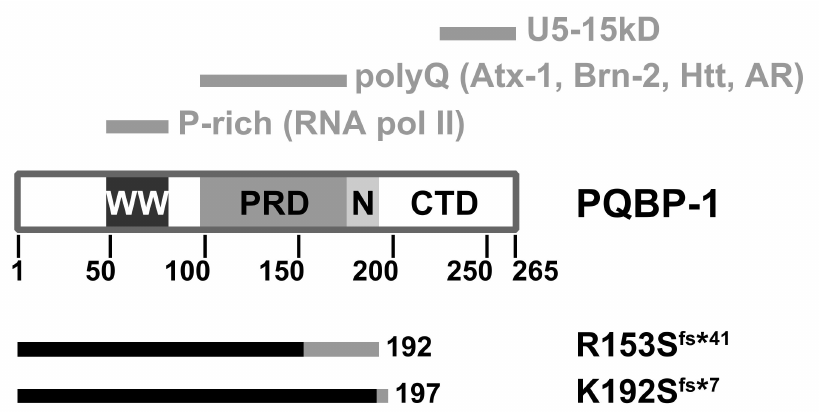
Figure 2. Domain architecture of the polyglutamine tract-binding protein (PQBP-1). WW: WW domain; PRD: Polar amino-acid-rich domain; N: Nuclear localisation signal; CTD: C-terminal domain. The top grey bars indicate the respective regions which mediate molecular interactions. The bottom bars indicate the respective truncation mutants: The native sequence is in black, whereas the non- native (due to frameshift) is in grey. Atx-1: Ataxin-1; Htt: Huntingtin; AR: Androgen